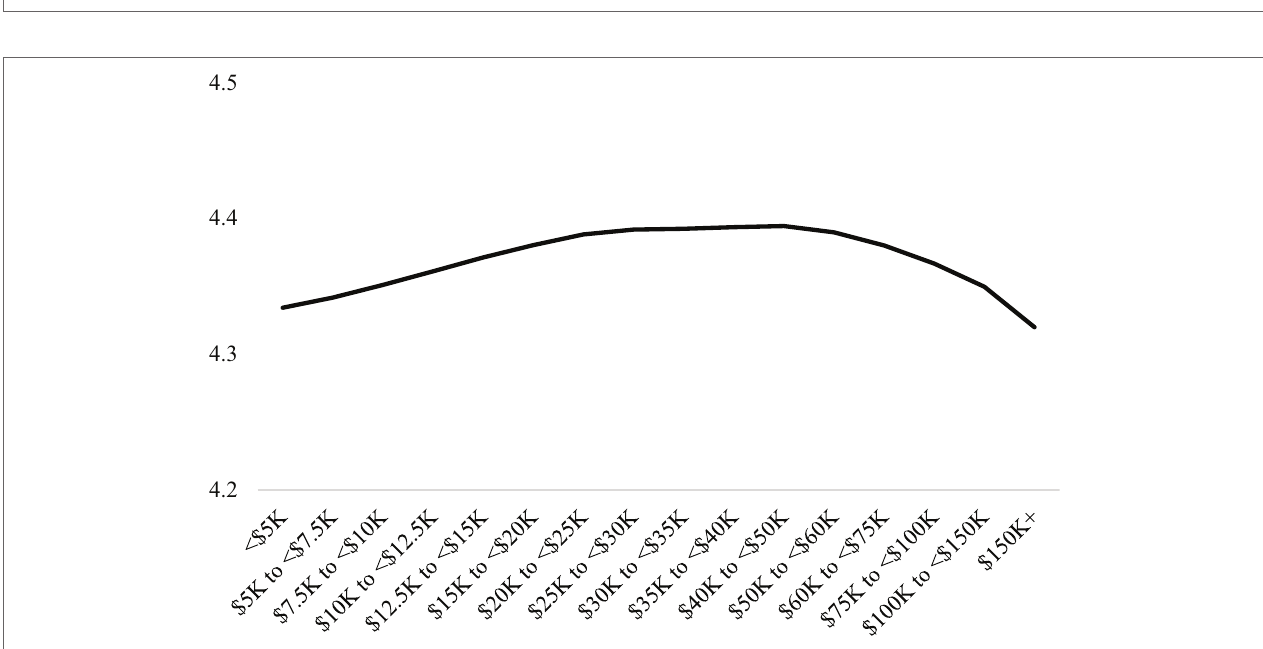
FIGURE 1 | Predicted values of average individual happiness in the American Time Use Survey (ATUS) at the 16 values of the family income variable without and with controls. Covariates at means. 95% CI.